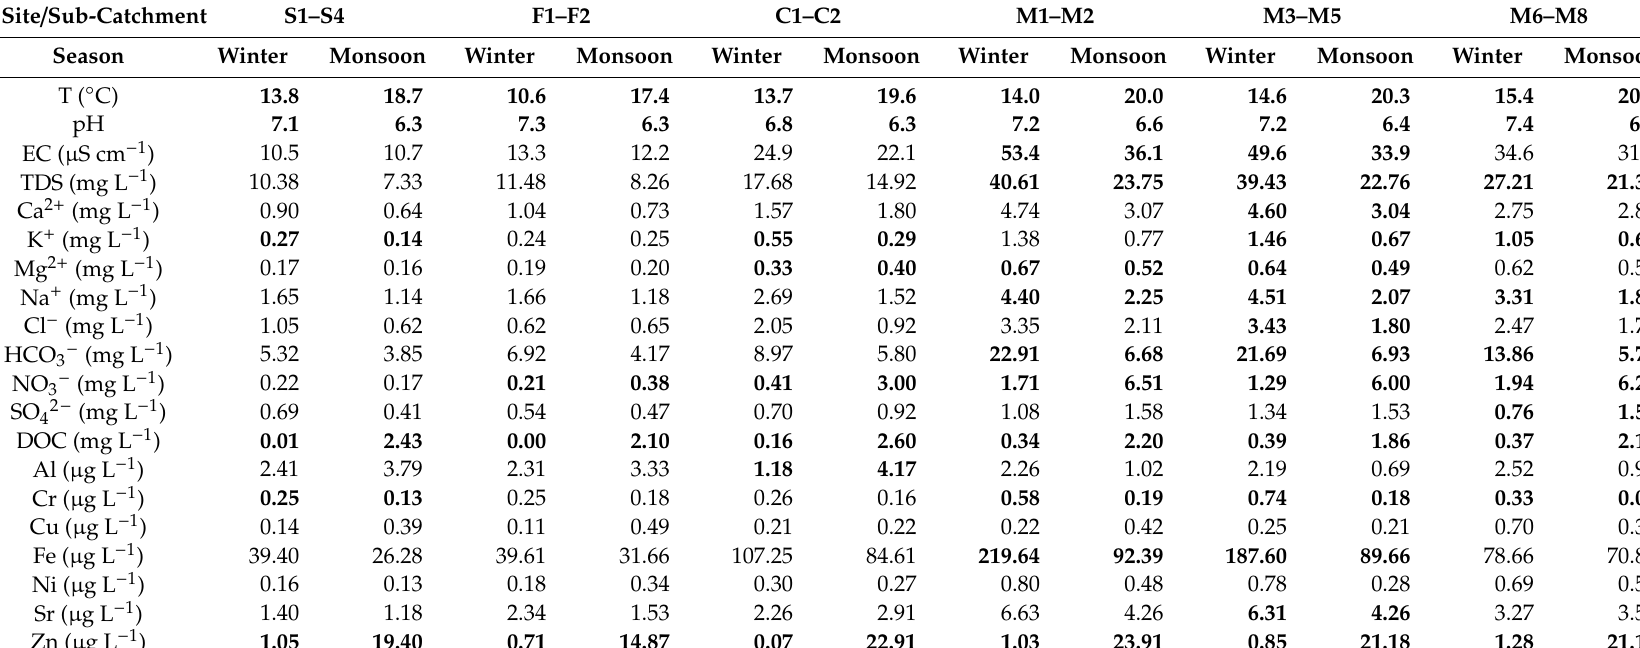
Table 3. Mean values of the physico-chemical variables during winter and monsoon seasons within the Nongkrem and Umiew nested catchments system. Variables significantly di ff erent between winter and monsoon seasons with p < 0.05 are in given bold (based on the Mann–Whitney test). T—temperature, EC—electrical conductivity, TDS—total dissolved solids, and DOC—dissolved organic